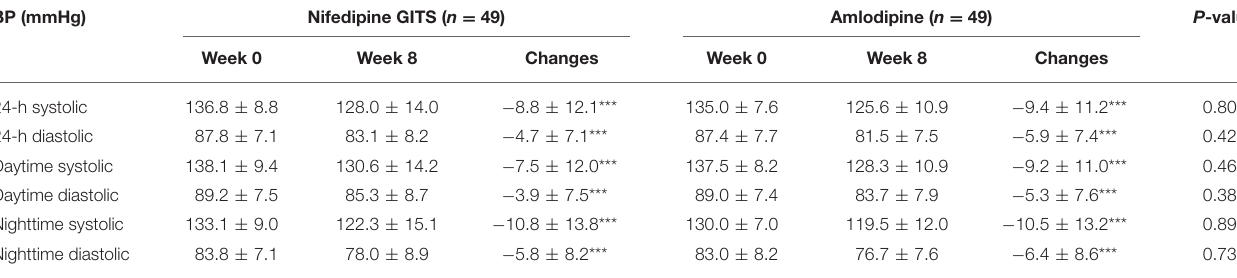
TABLE 3 | Comparison of ambulatory BP reduction between nifedipine GITS and amlodipine.